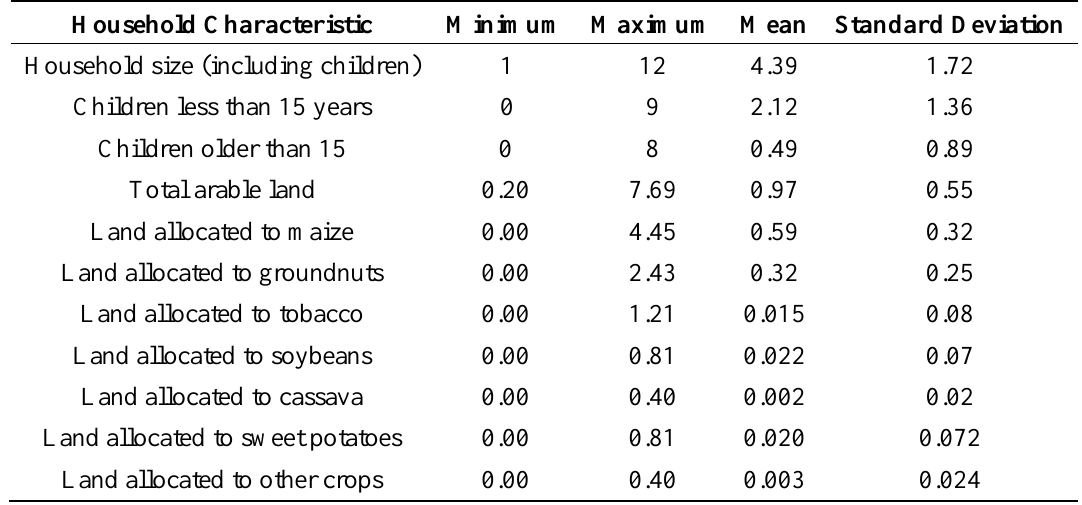
Table 2. Descriptive summary statistics of field survey data collected (land is in